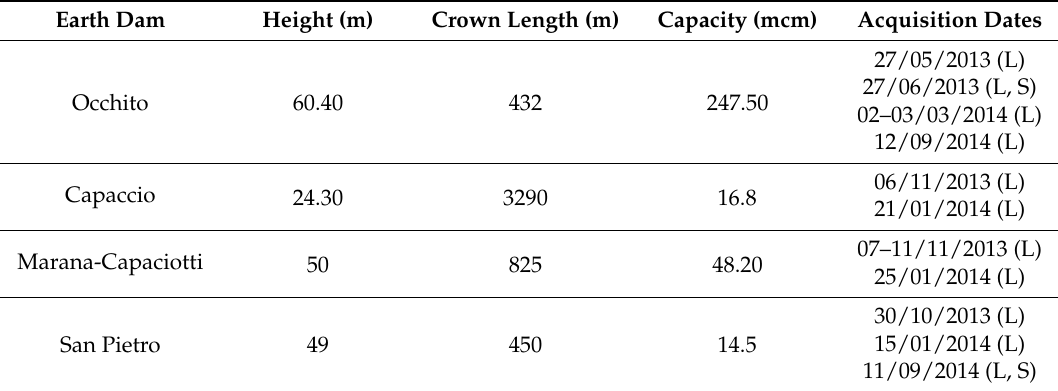
Table 1. Earth dam characteristics and acquisition dates (L = SAR modality, S = RAR modality).